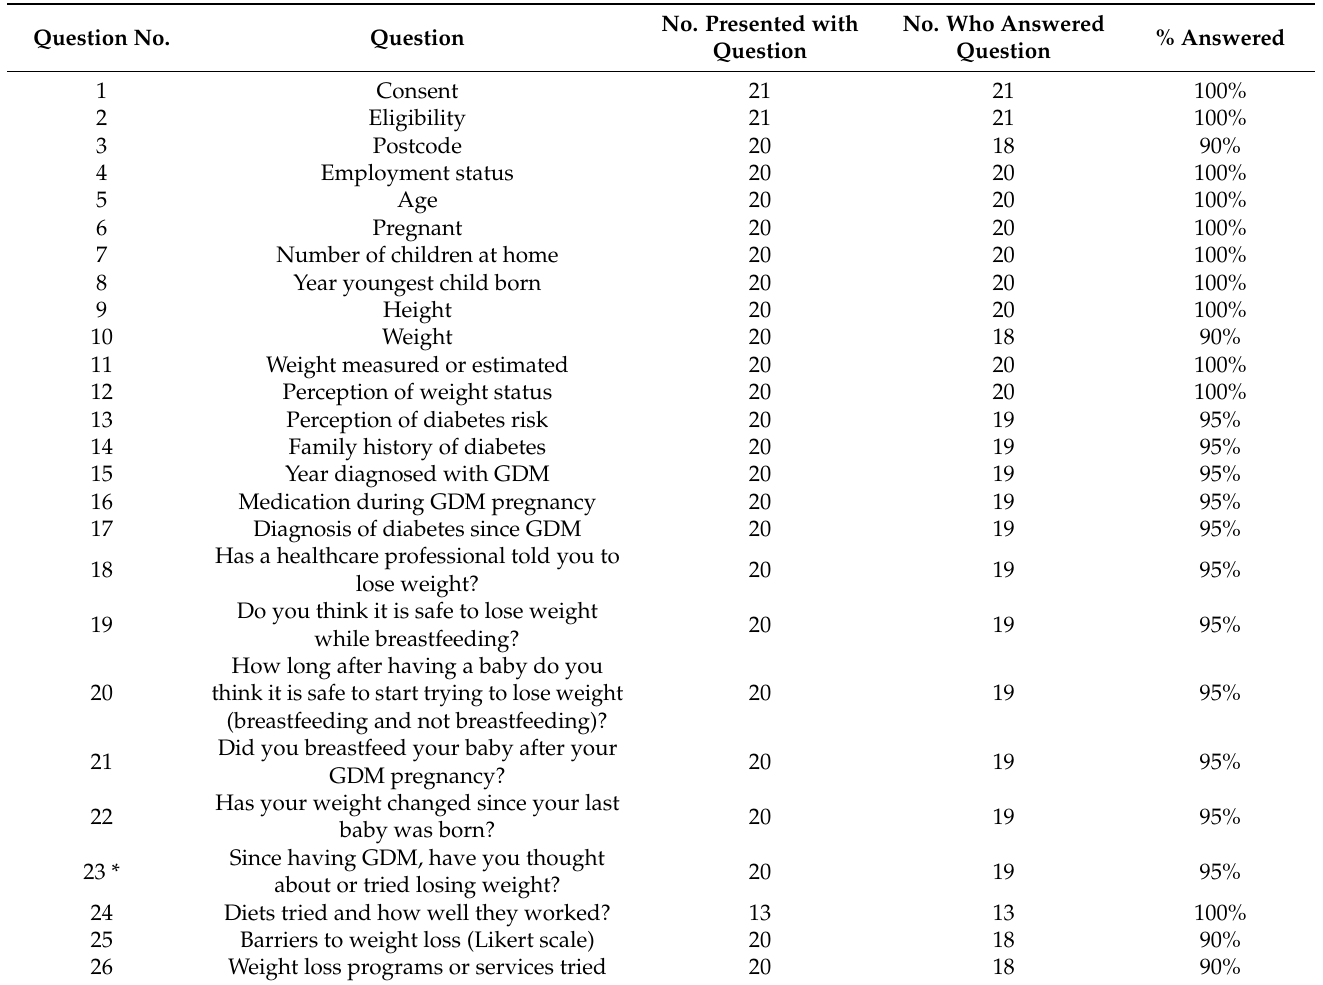
Table 2. Number and percentage of questions answered for each item in the pilot